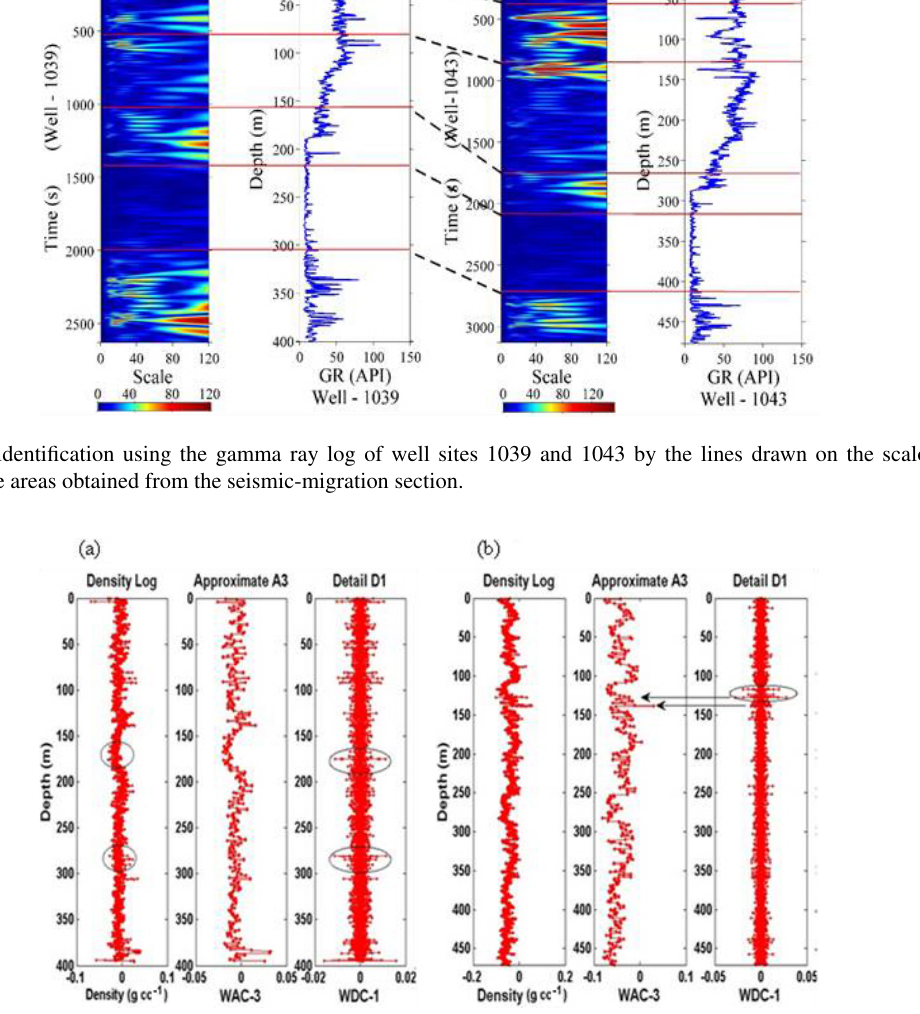
Figure 9. (a) Discrete detailed and approximate coefficients; spikes obtained in detailed coefficients represent the possible fracture zone at well site 1039. (b) The discrete detailed and approximate coefficients; the spikes obtained in detailed coefficients represent the possible fracture zone at well site